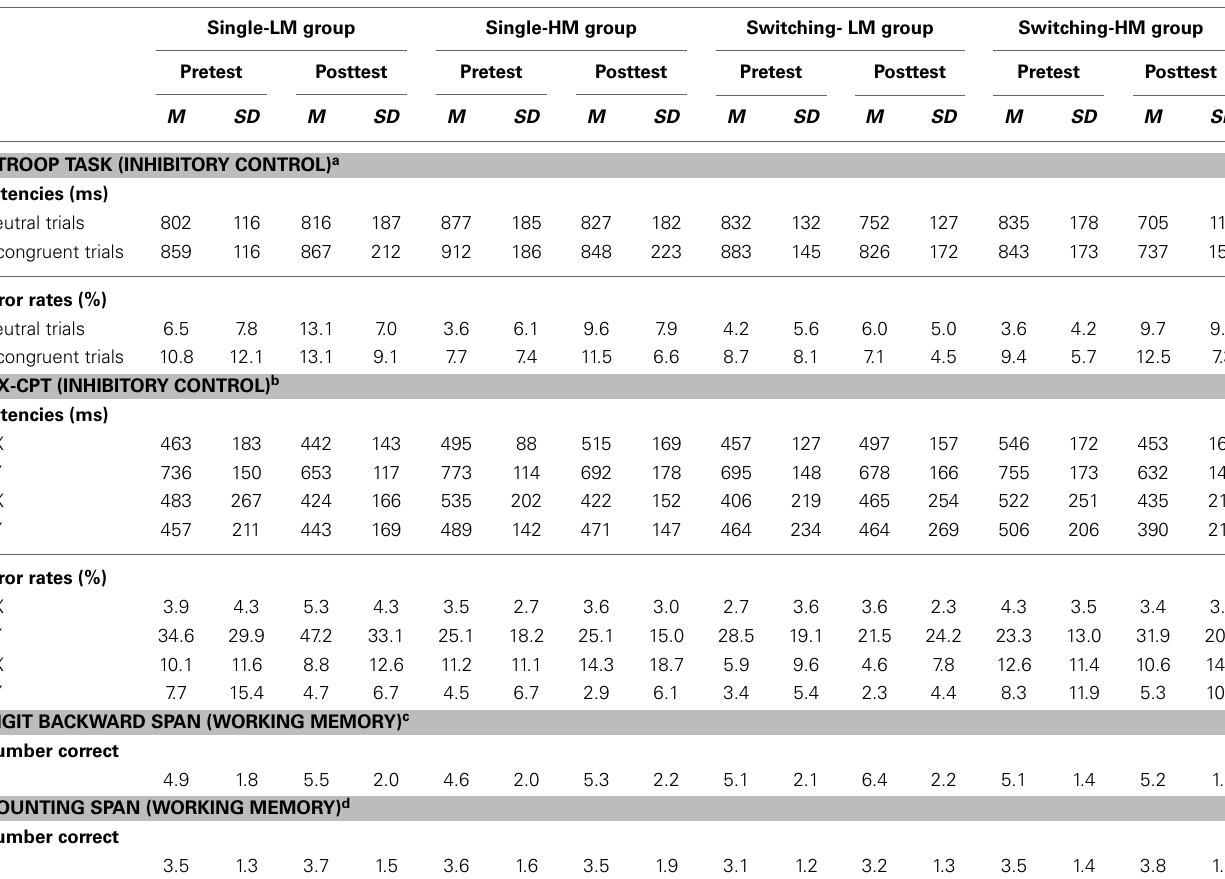
Table 4 | Performance on far-transfer tasks as a function of Training Group (single-LM, single-HM, switching-LM, switching-HM) and Session (pretest,